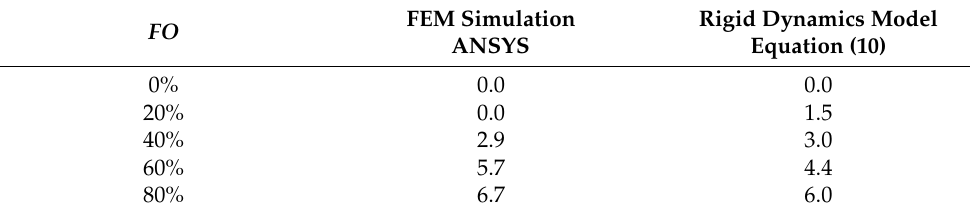
Figure 14. Schematic diagram of yaw error. Table 3. Yaw angle predictions for the No. 4 platform ( µ rad).